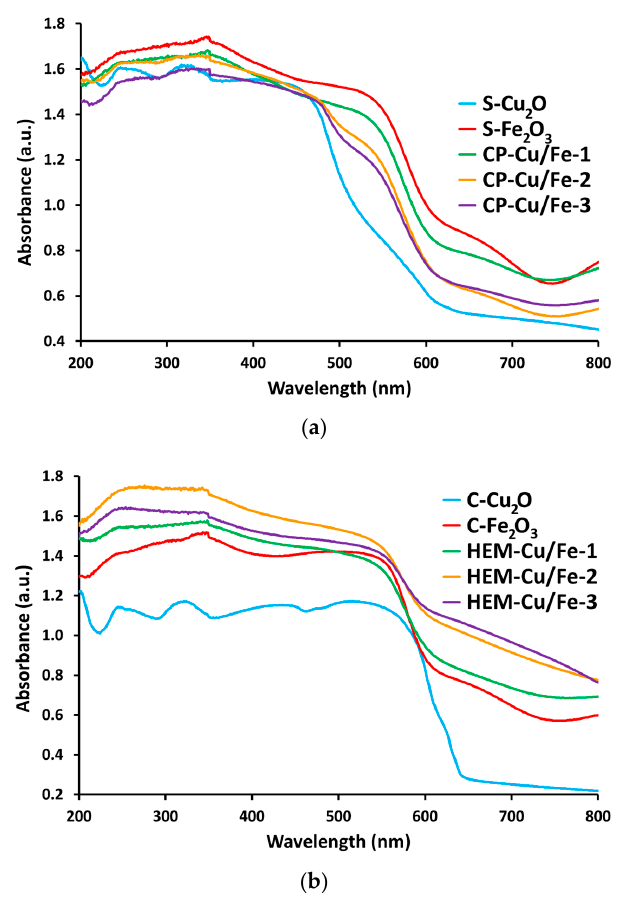
Figure 5. UV-Visible DRS for Cu/Fe mixed oxides pairs prepared by ( a ) CP and by ( b ) HEM.